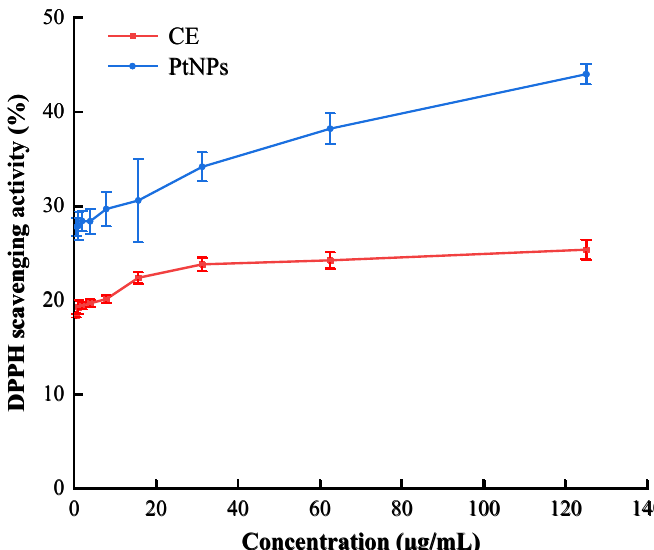
Figure 9. DPPH scavenging activity of PtNPs and CE.